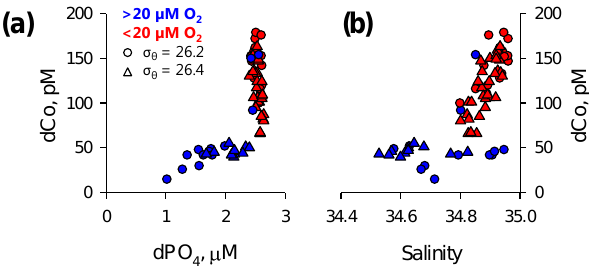
Figure 8. Transition in dCo cycling at the OMZ boundary in the upper South Pacific thermocline. (a) Isopycnal windows centered at σ θ = 26.2 ± 0.1kgm − 3 (circles) and σ θ = 26.4 ± 0.1kgm − 3 (tri- angles) show PO 4 -coupled cycling in oxygenated waters (blue) but not in OMZ waters with <20µMO 2 (red). (b) In the OMZ, dCo follows salinity, indicating mixing between a high dCo endmember at a salinity of 35.0 and a fresher water mass that is low in